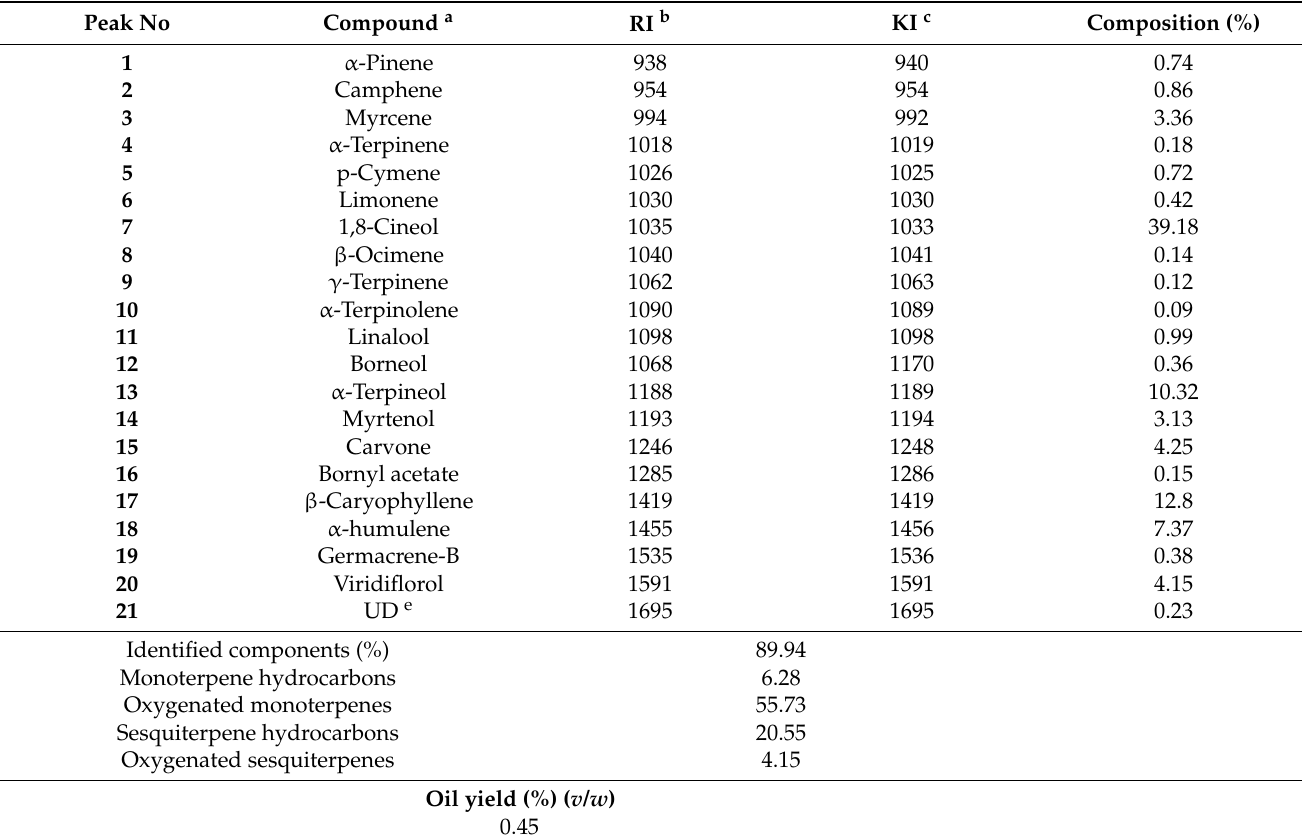
Table 2. Chemical composition of S. officinalis L. EO.